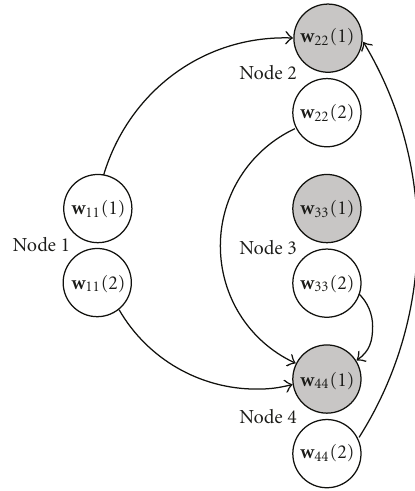
Figure 5: Possible graph describing dependencies of estimations problems for DANSE 2 applied to the acoustic scenario described in Section